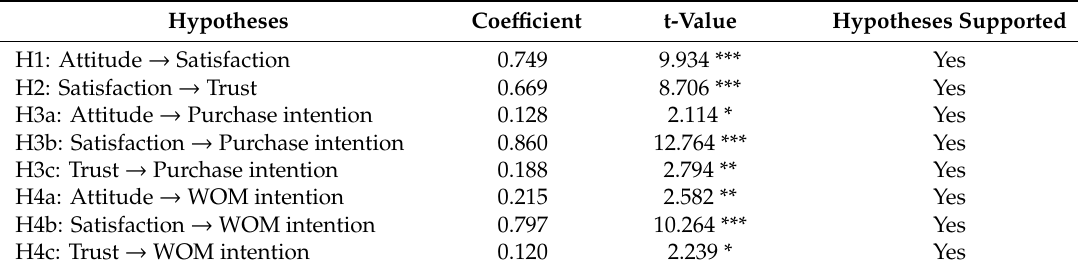
Table 5. Structural model